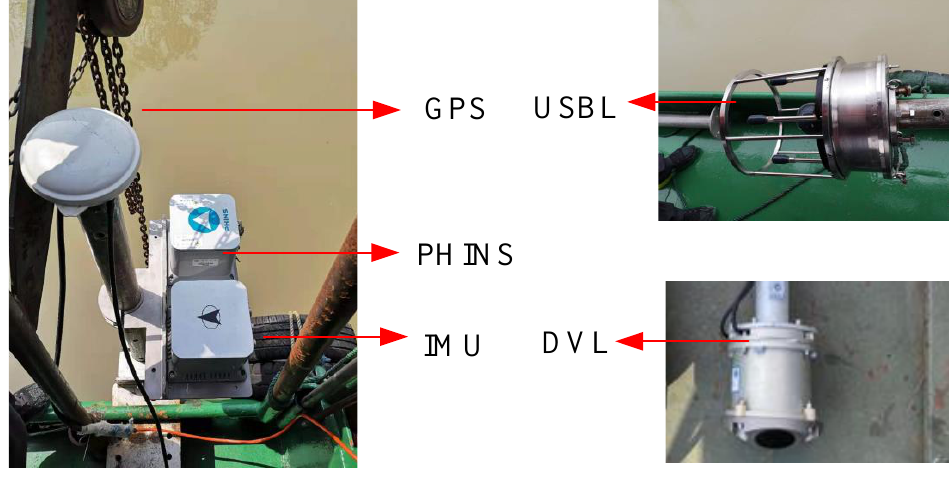
Figure 6. Diagram of the field test equipment.